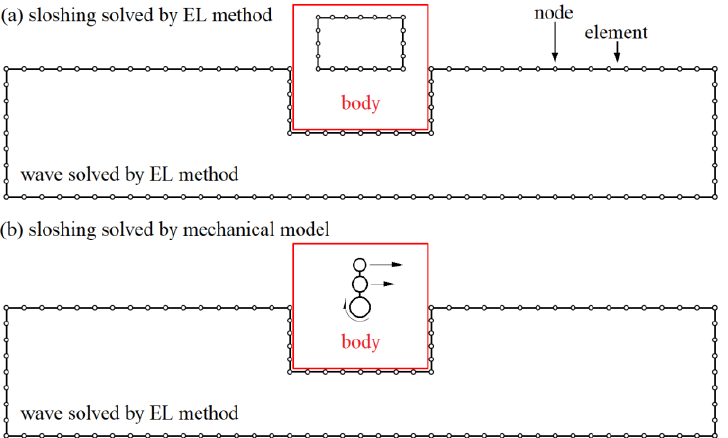
Figure 7. The numerical configurations for ( a ) EL method; ( b ) mechanical model, in the FSI problem (not to scale).